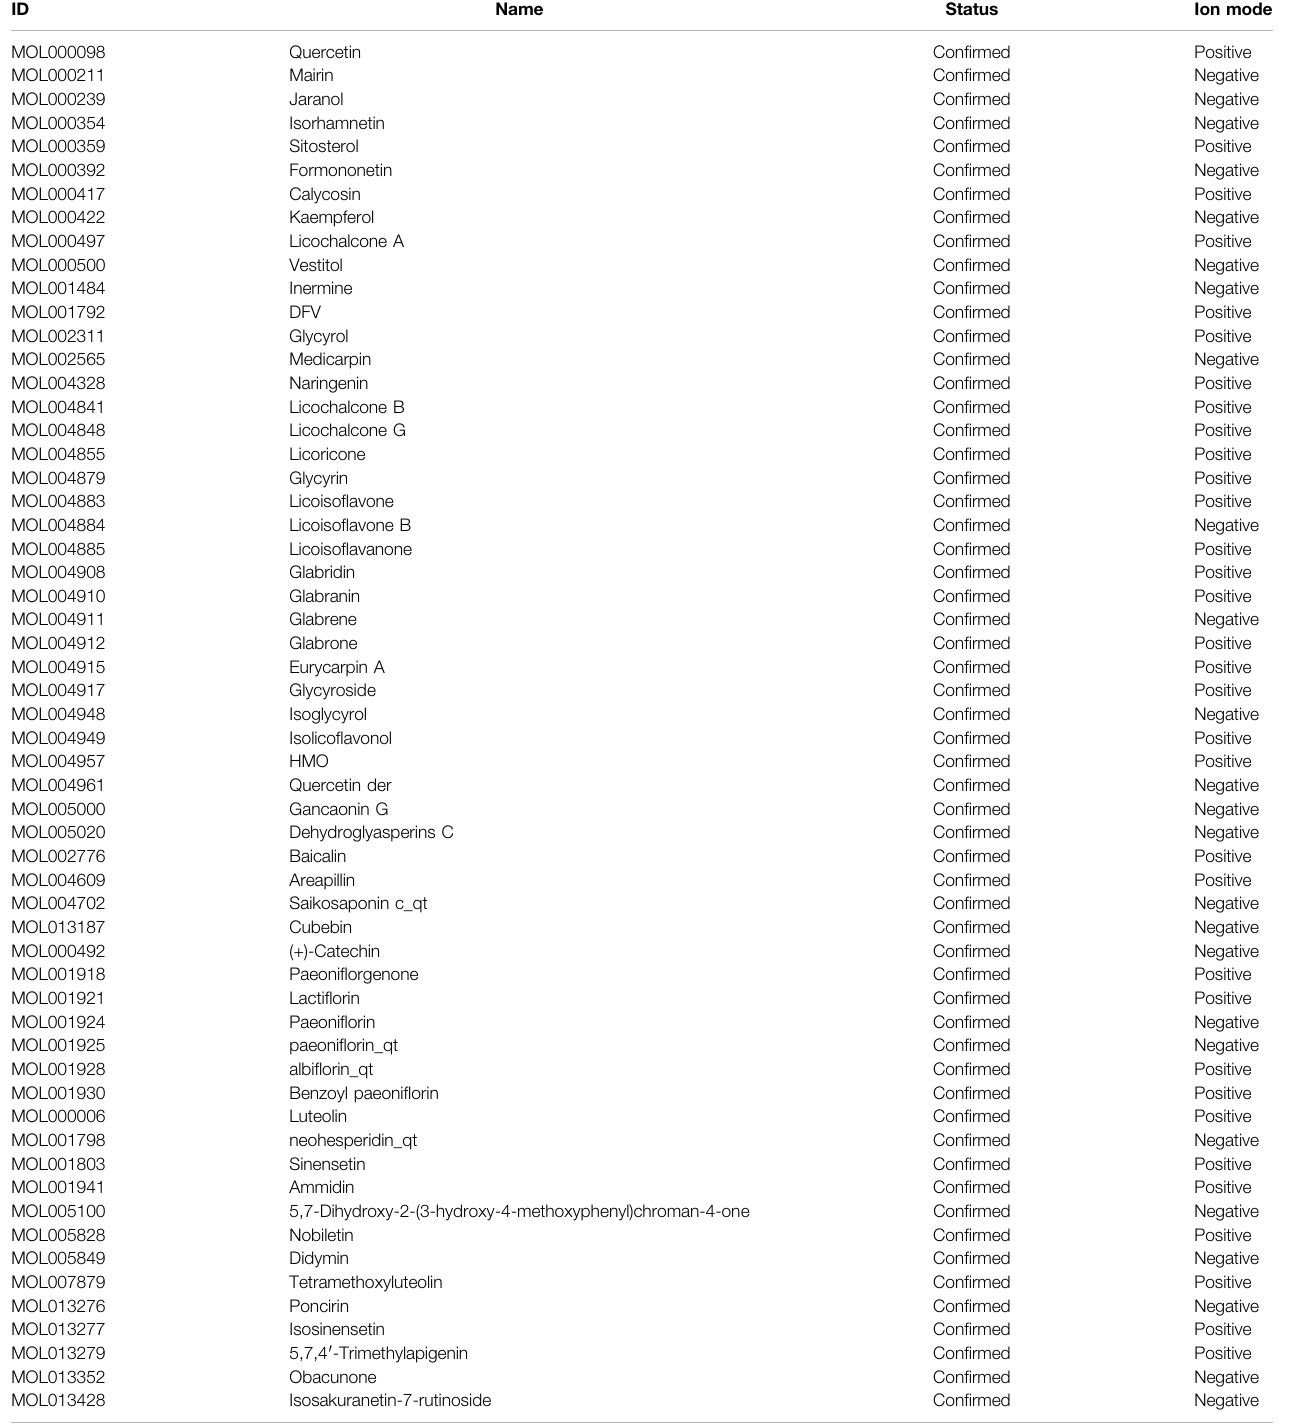
TABLE 2 | Identi fi ed bioactive compounds in SNS from UPLC-ESI-MS/MS Analysis.